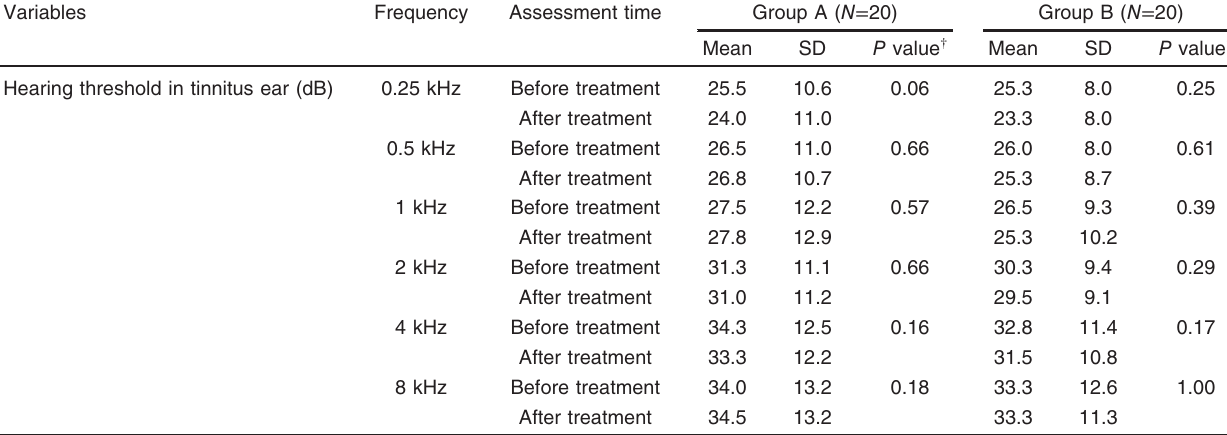
Table 5 Within-group comparison of hearing threshold in affected ear before and after treatment Variables